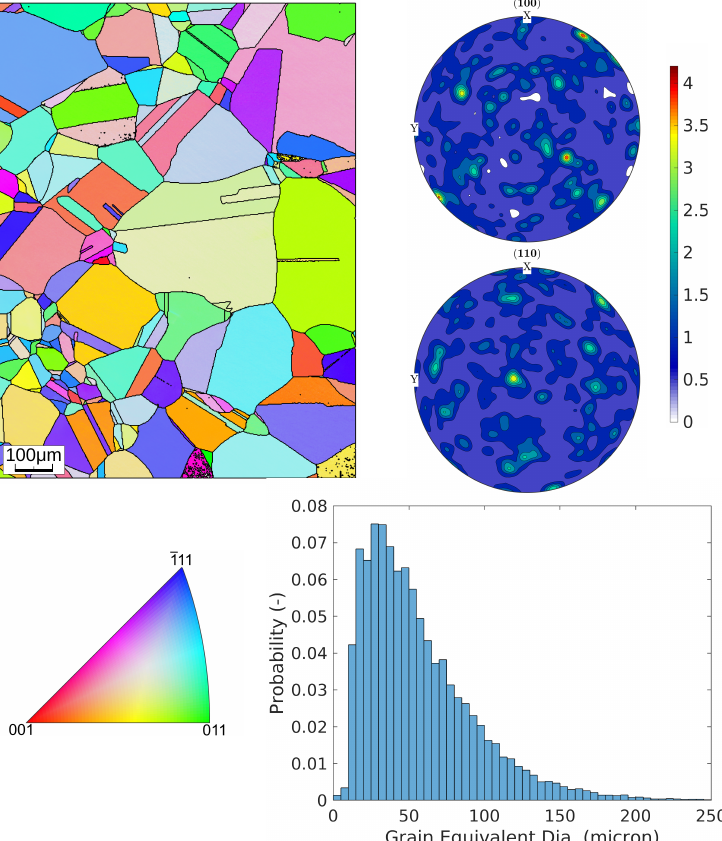
Figure 2. ( top left ) IPF-Z plot of one of the EBSD data sets, ( bottom left ) corresponding IPF key, ( top right ) pole figure contour plot of the ODF estimated by combining all EBSD data sets (i.e., ≈ 19,000 grains), ( bottom right ) the grain equivalent diameter